Question: Compose a caption that would accompany this figure in a paper.
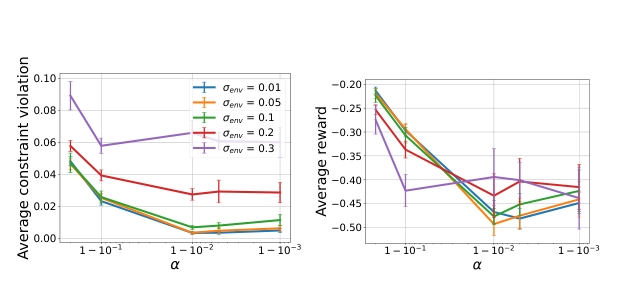
Answer: Impact α on the execution performance of RANCB. Av- erage constraint violation per step (left) and average reward (right).